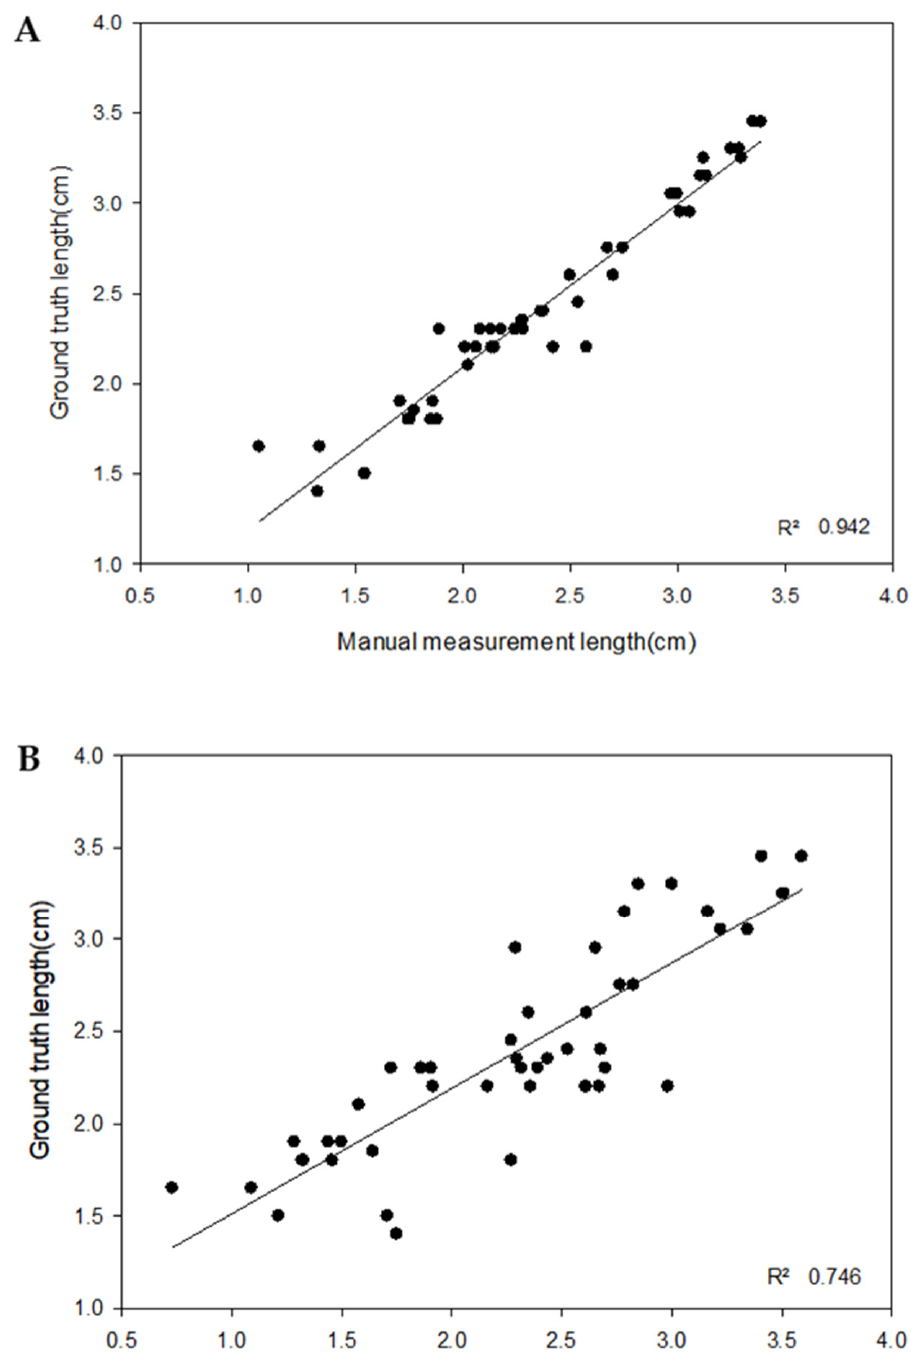
Figure 16. Comparison of automatically measured leaf width with ground truth data: ( A ) manual measurement and ( B ) segmentation and automatic measurement.